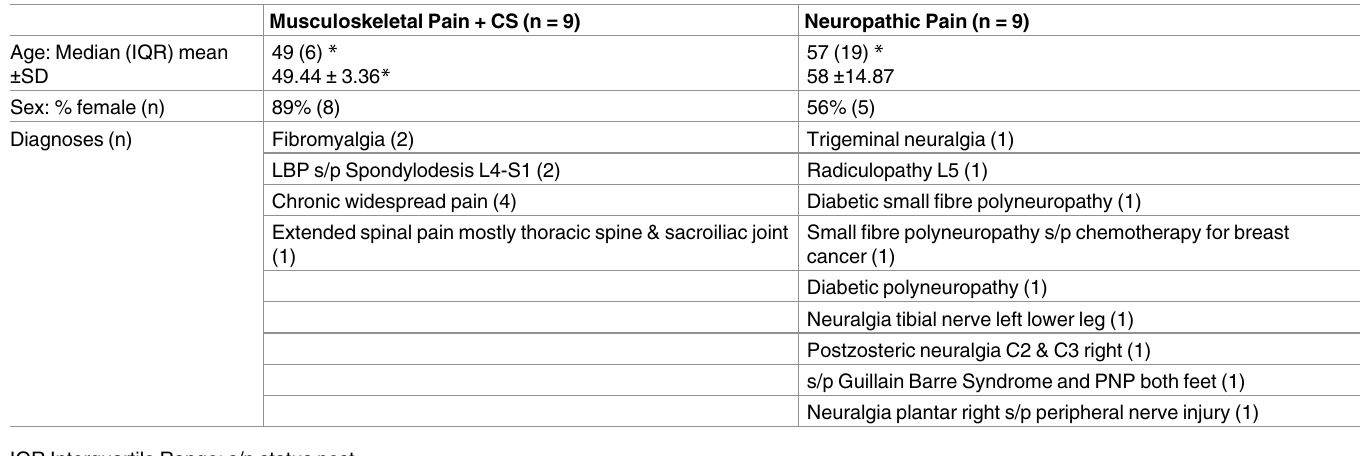
Table 3. Age, sex and diagnoses of included